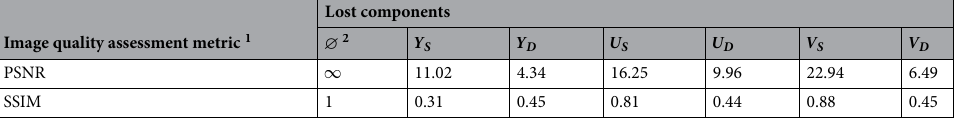
Table 5. The quality of the reconstructed image when one component is lost. The experimental results are 1 obtained on the DRIVE dataset. The difference evaluation between the reconstructed image and the original 2 image. It means no loss of components.